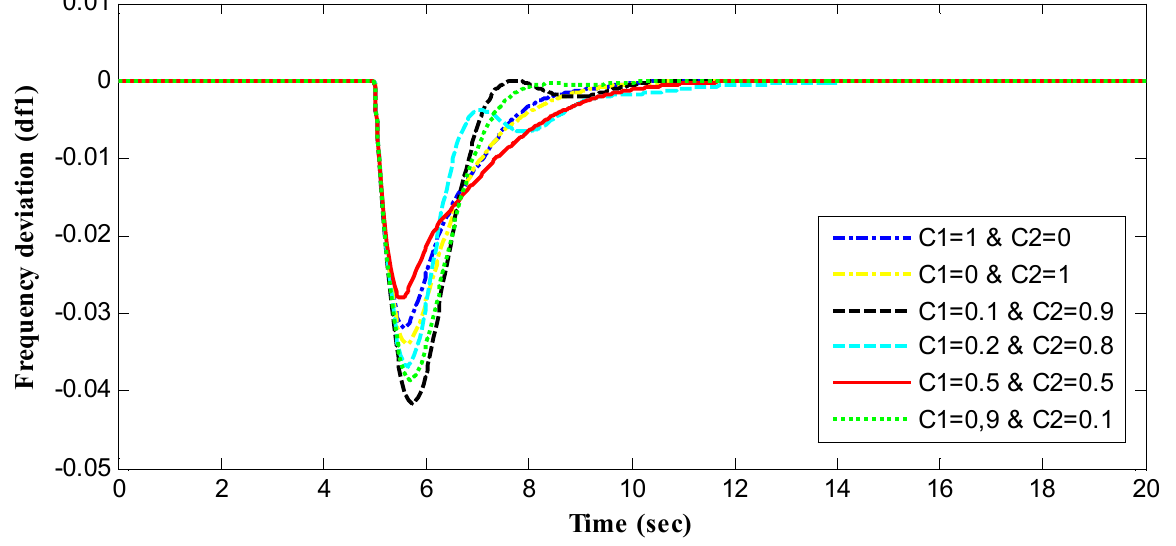
Figure 9. Frequency deviation 𝛥𝑓 (cid:2869) for area1 using the proposed IB-WGFF.